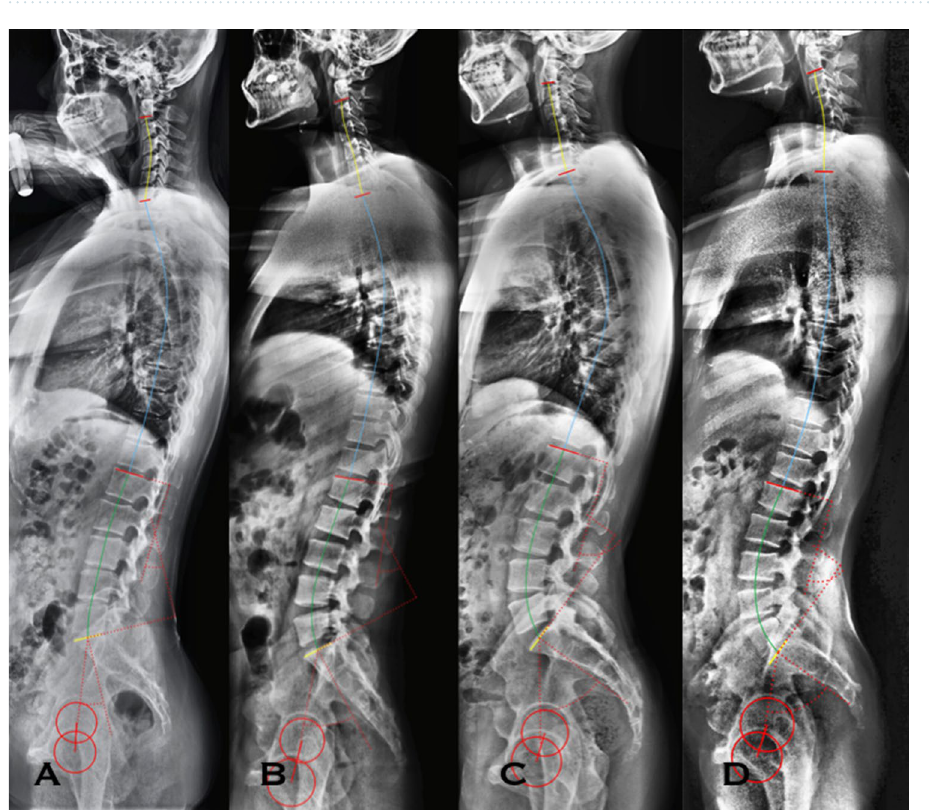
Figure 5. The graphs show the correlation between pelvic incidence and lumbar lordosis morphology. Across the stratification by PI value, from very low PI to high PI group, lumbar lordosis increases, and lumbar lordosis apex migrates higher. A with very low PI, PI = 21°, LL apex = L5/S1, LL = −30°, PLL = −1°; B with low PI, PI = 39°, LL apex = L4/5, LL = −38°, PLL = −7°. C with moderate PI, PI = 53.0°, LL apex = L4, LL = −60°, PLL = −20°. D with high PI, PI = 64°, LL apex = L3/4, LL = −70°, PLL = −28°. PI pelvic incidence, LL apex, lumbar lordosis apex, LL lumbar lordosis, PLL proximal lumbar